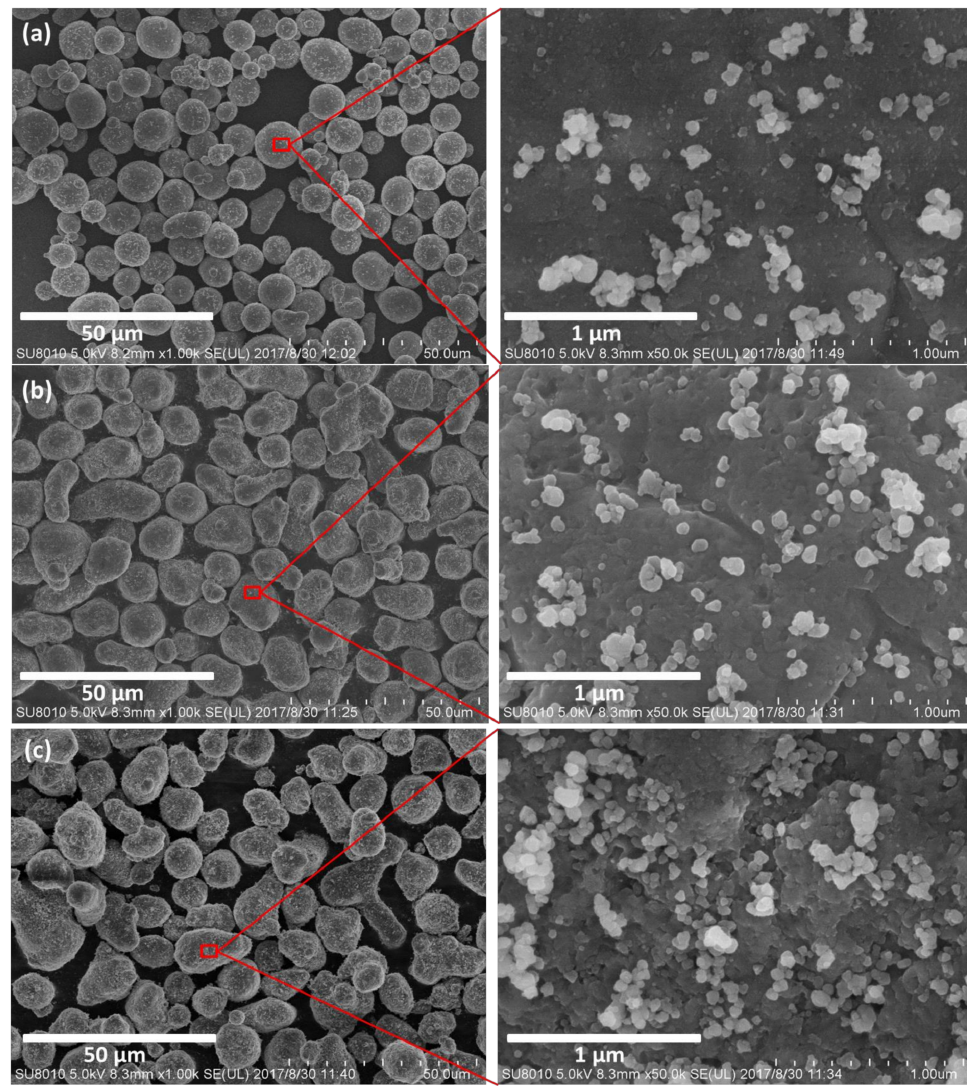
Figure 4. The aluminium powder after the mixing with SiC nanoparticles: ( a ) Al-1 wt % SiC; ( b ) Al-2 wt % SiC; ( c ) Al-3 wt %